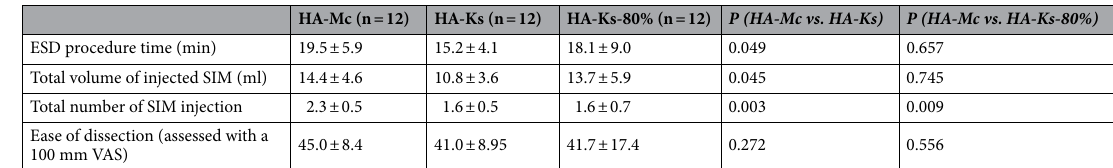
Table 1. Comparison of ESD outcomes in an ex vivo porcine stomach model. Statistics presented as mean ± SD with t-tests. ESD, endoscopic submucosal dissection; VAS, visual analog scale; HA-Mc, sodium hyaluronate-based submucosal injection material (MucoUp®); HA-Ks, sodium hyaluronate-based submucosal injection material (Ksmart®); HA-Ks-80%, HA-Ks diluted to 80% concentration in